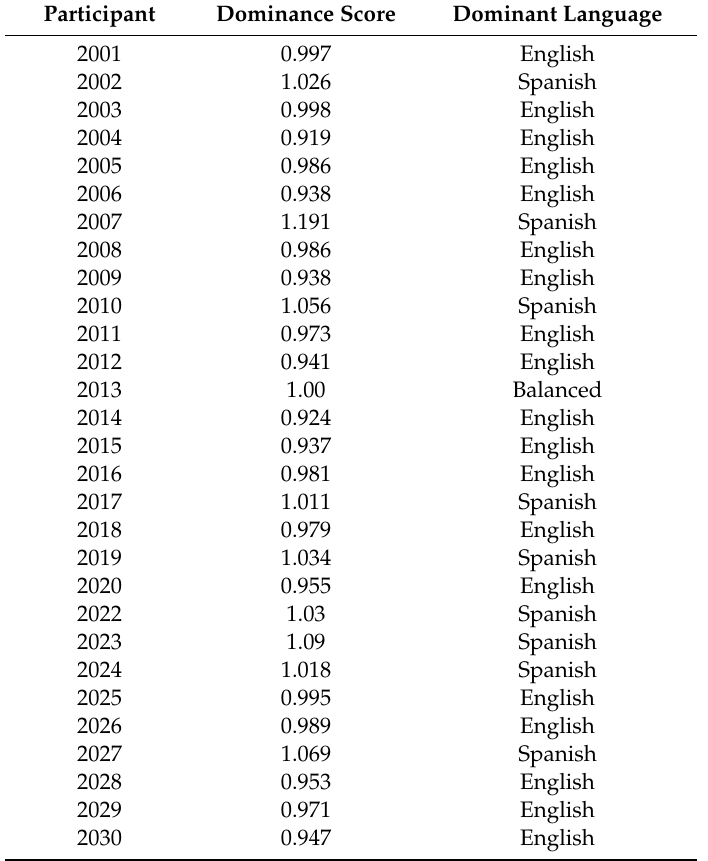
Table A5. Repetition Task individual dominance scores on a ratio of < 1 (English) to > 1